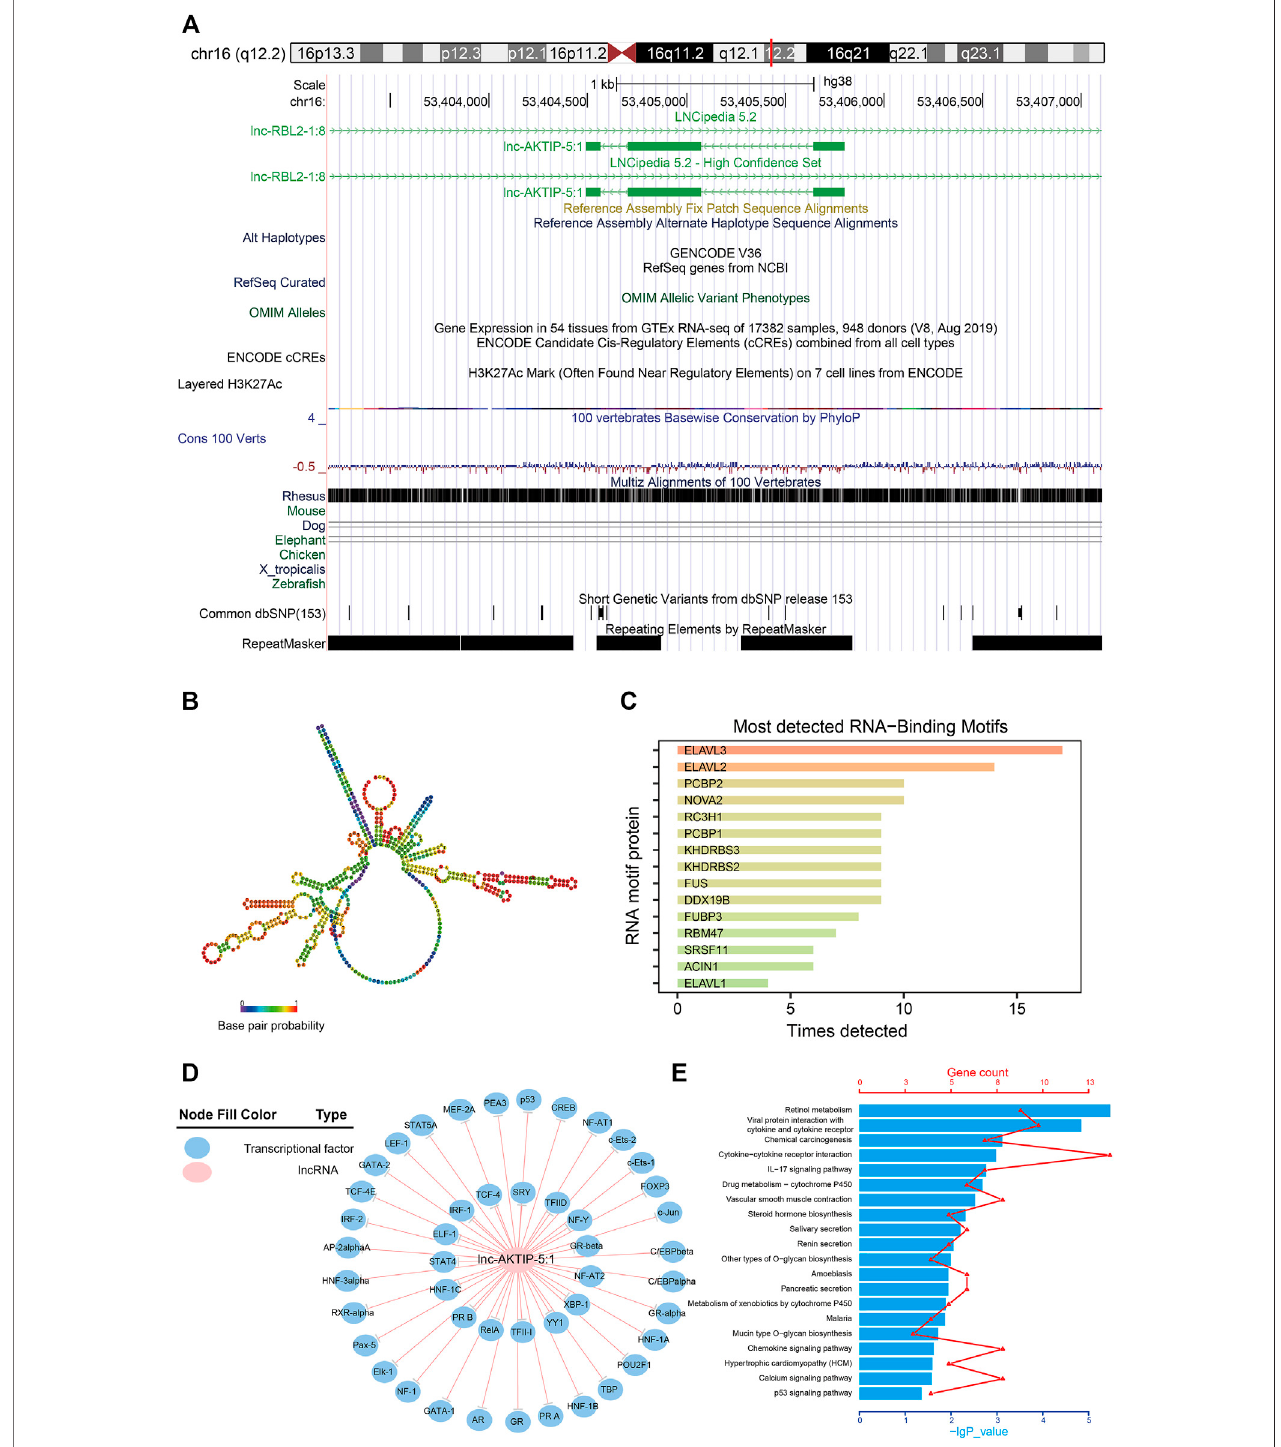
FIGURE5| Bioinformaticsanalysisoflnc-AKTIP (A) Chromosomelocationoflnc-AKTIP (B) Optimalsecondarystructureforlnc-AKTIP (C) Interactionbetweenlnc- AKTIPandRNAmotifproteins (D) Interactionbetweenlnc-AKTIPandtranscriptionfactors. Lnc-AKTIPisindicatedbyaredcircle.Thetranscription factorsareindicated by blue circles (E) Pathway annotation of the mRNAs coexpressed with lnc-AKTIP.